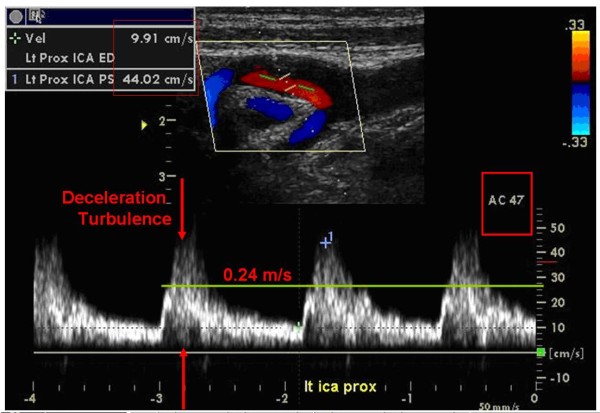
End Acceleration Velocity Followed by Deceleration Turbulence. Cursor 1 was placed by the examiner at the traditional location for peak systolic velocity. The Green line was added by the UWURC Reader at the End Acceleration Velocity; the red annotation was added by the UWURC Reviewer. The Doppler Angle is 47 degrees